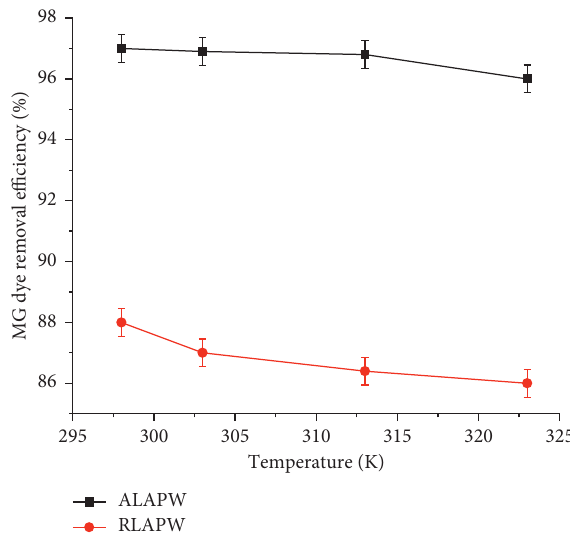
Figure 6: Effect of initial MG dye concentration on MG dye re- moval by ALAPW and RLAPW at pH 4 (ALAPW) and pH 6 (RLAPW), adsorbent dose 0.2g, contact time 60 min, and tem- perature (298 K) with agitation speed 200rpm.